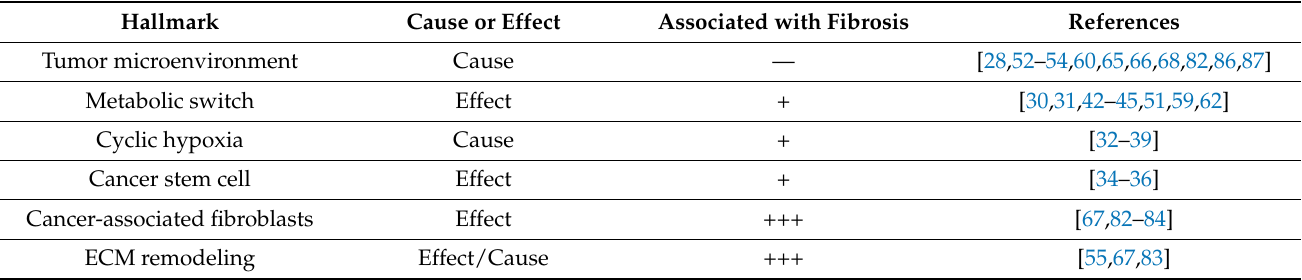
Table 1. Cancer hallmarks associated with hypoxia.